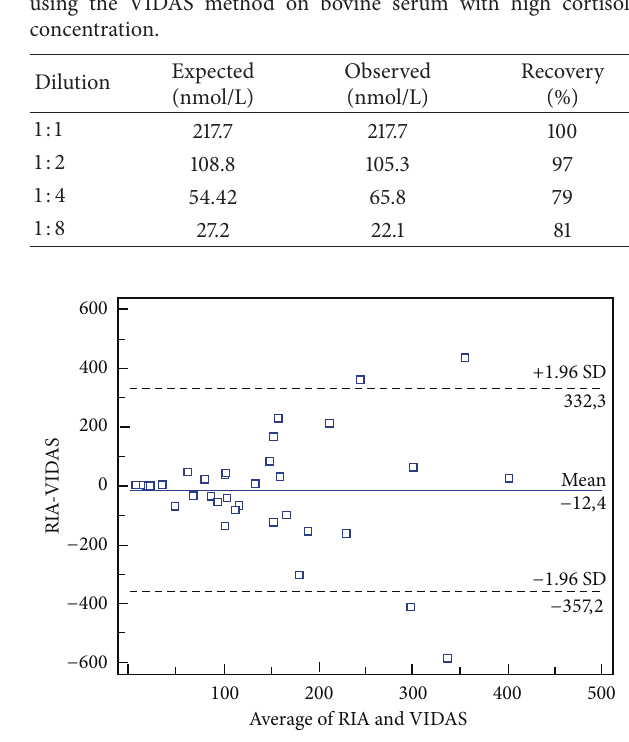
Figure 1: Comparison between the VIDAS assay and the RIA reference method for cortisol serum concentration (nmol/L) in 40 cows Bland-Altman plot. The solid line indicates the mean of difference, and dashed lines indicate limits of agreement, which are defined as the mean difference plus and minus 1.96 times the standard deviation of the